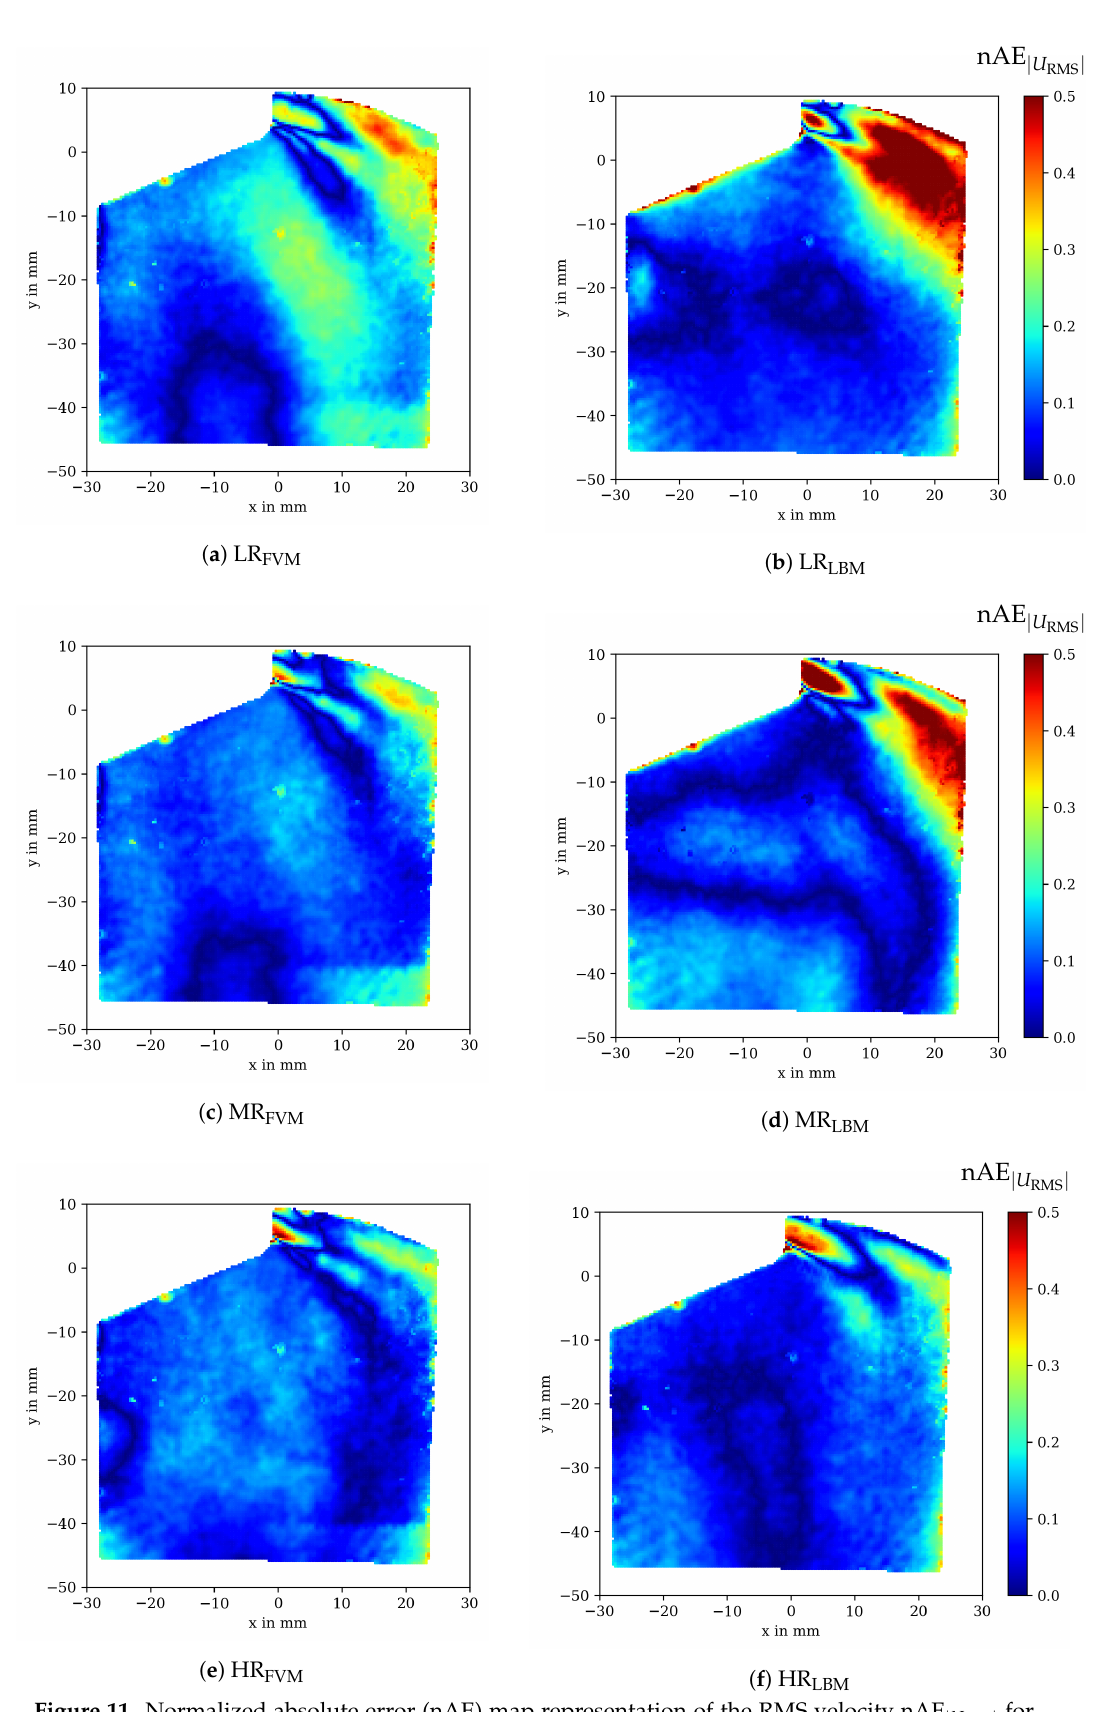
Figure 11. Normalized absolute error (nAE) map representation of the RMS velocity nAE in-cylinder flow against PIV data for OpenFOAM (left) and OpenLB (right) at different grid